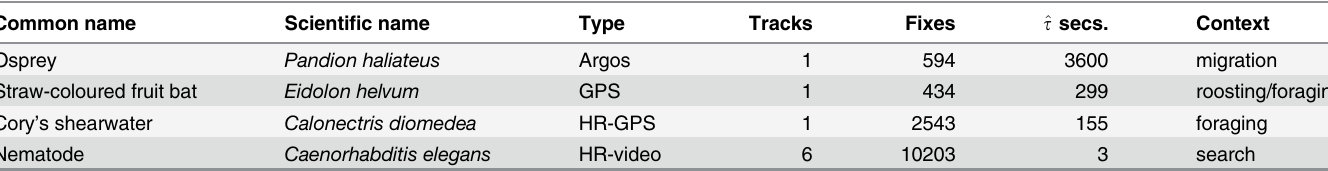
Table 1. Empirical